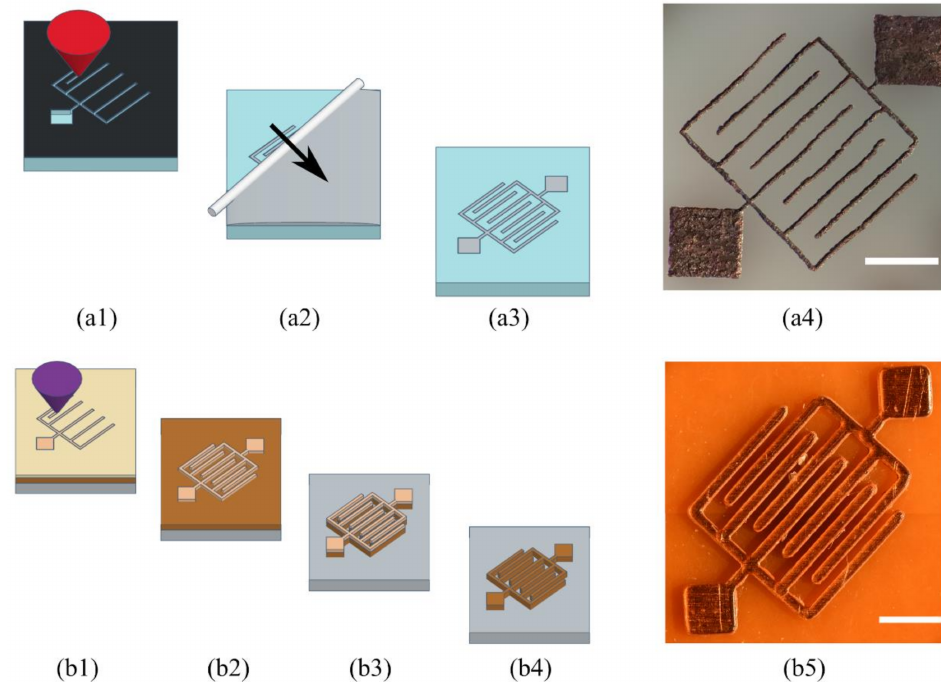
Figure 5. Microelectrodes fabrication processes: local laser ablation of PMMA etches interdigitated microchannels that are filled with carbon paste using doctor blading ( a1 – a4 ) and DLW is used on a thin Loctite layer as a protective coating to chemically etch a PCB copper board ( b1 – b5 ) Scale bars are 500 µ m and 1 mm for ( a4 ) and ( b5 )